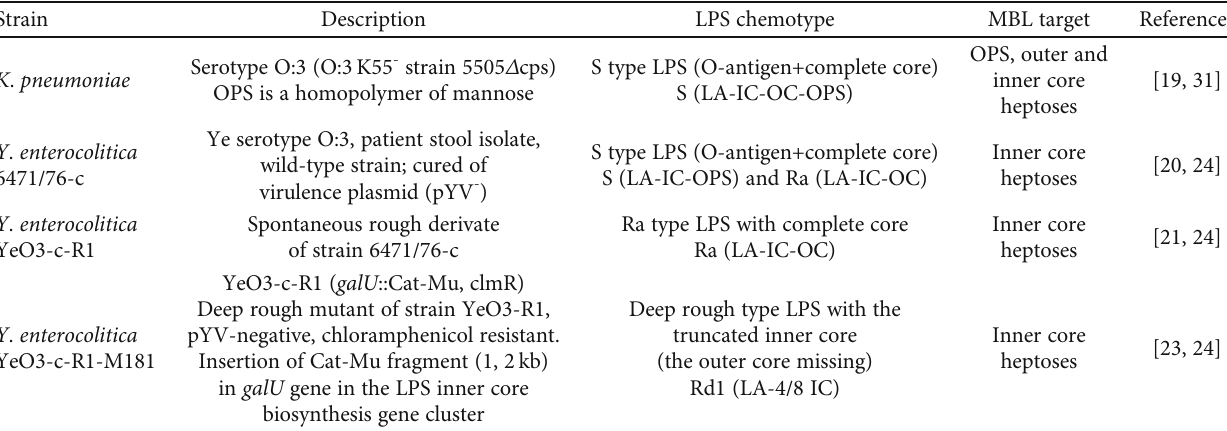
Table 1: Description of bacterial strains used in this study.